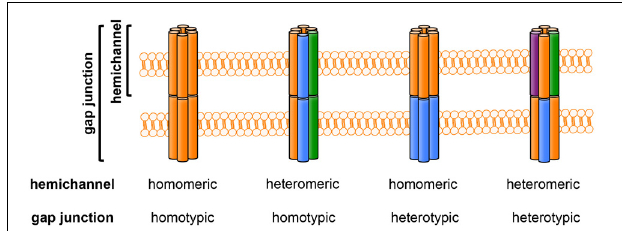
FIGURE 2 | The composition of gap junctions and hemichannels. Each colored column (orange, blue, green, or purple) represents a different connexin isoform. Hemichannels may be homomeric (composed of one connexin isoform) or heteromeric (composed of more than one connexin isoform). Gap-junction channels may be homotypic (formed by identical hemichannels) or heterotypic (formed by different hemichannels).